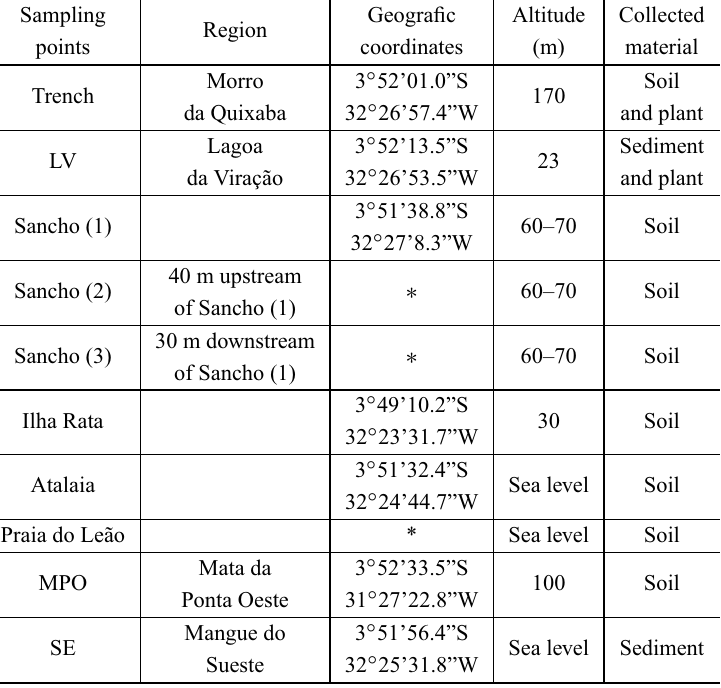
Study sites in Fernando de Noronha.